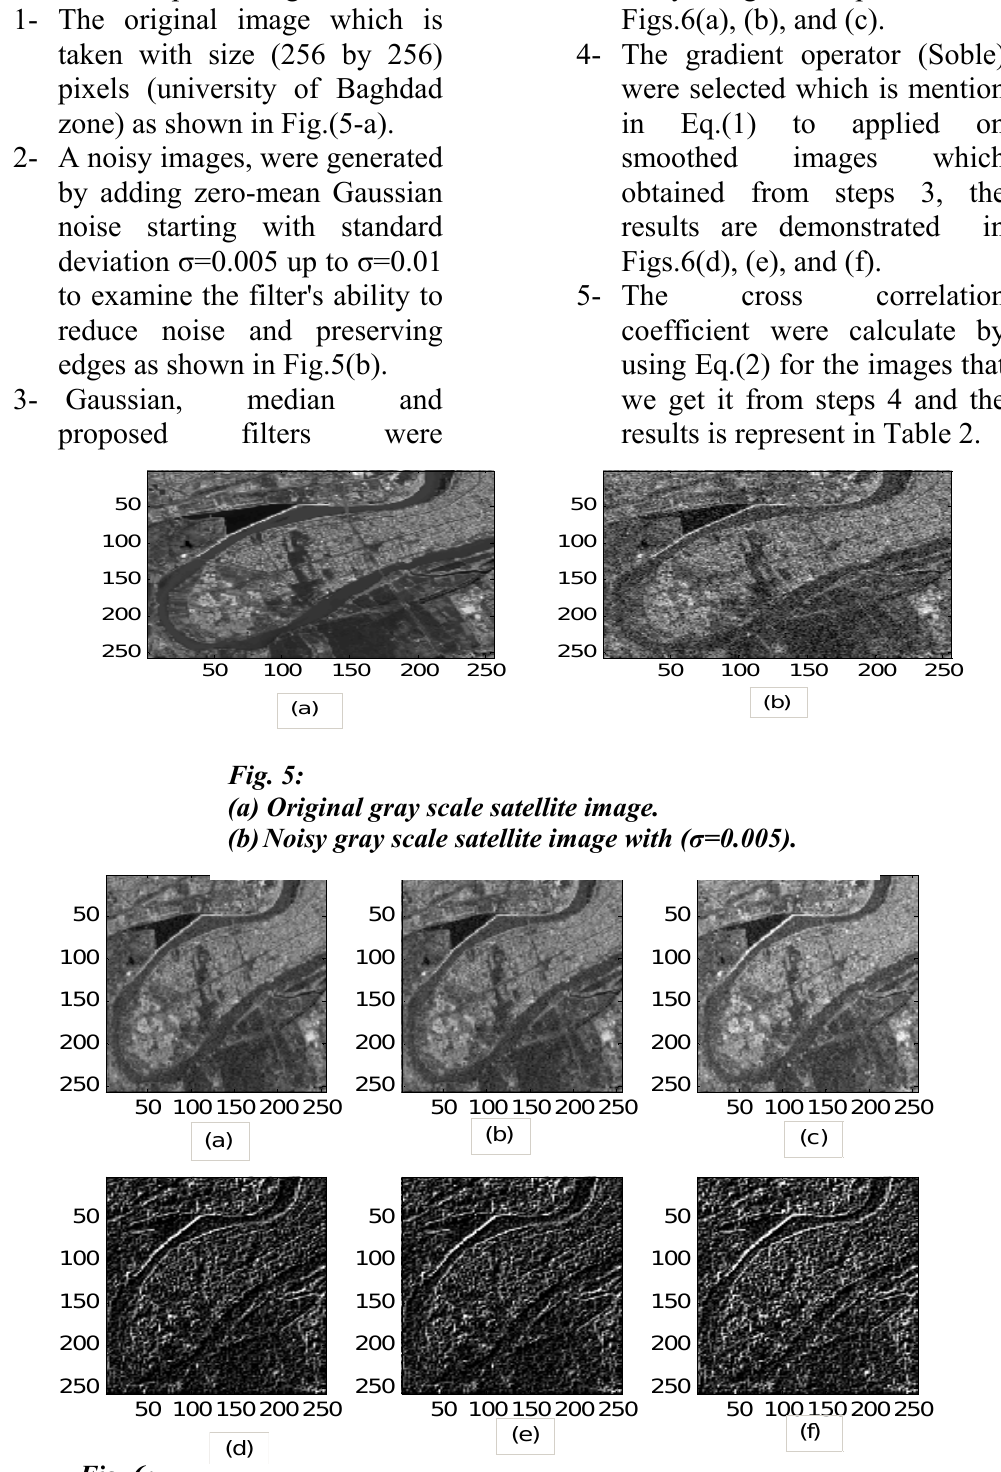
Fig. 6: (a) Filtered noisy gray satellite image by Gaussian filter. (b)Filtered noisy gray satellite image by median filter. (c)Filtered noisy gray satellite image by proposed filter. (d) Sobel operator in the noisy gray satellite image by Gaussian filter. (e)Sobel operator in the noisy gray satellite image by median filter. (f)Sobel operator in the noisy gray satellite image by proposed